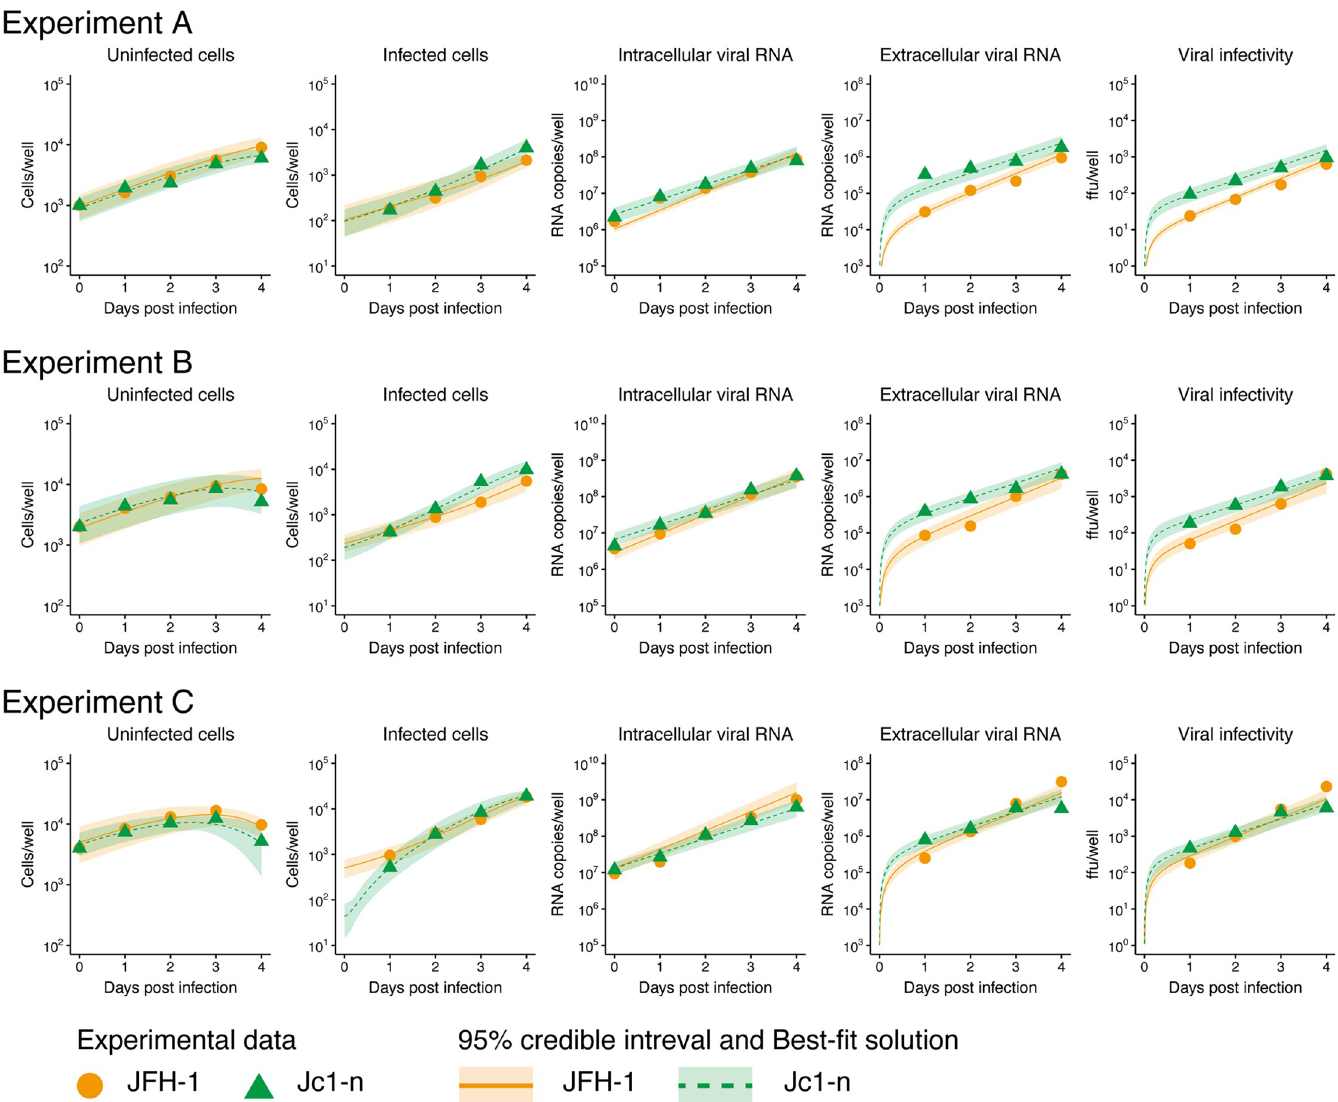
Fig 2. Dynamics of HCV JFH-1 and Jc1-n infection in cell culture. Fitting of the mathematical model to the experimental data of HCV JFH-1 and Jc1-n infection in cell culture. Three different numbers of Huh-7 cells infected with either HCV JFH-1 or Jc1-n 1 day after inoculation were seeded (experiment A: 1,000, experiment B: 2,000, and experiment C: 4,000 cells per well) and chased to detect the following values at days 0, 1, 2, 3, and 4 post seeding (log 10 scale): numbers of uninfected and infected cells, amount of intracellular and extracellular viral RNA (copies/well), and extracellular viral infectivity (ffu/well) (orange circle: JFH-1, green triangle: Jc1-n). The shadowed regions correspond to 95% posterior intervals and the solid curves give the best-fit solution (mean) for Eqs 2–6 to the time-course dataset. All data for each strain were fitted simultaneously. The underlying data for this figure can be found in S1 Data. ffu, focus formation unit.